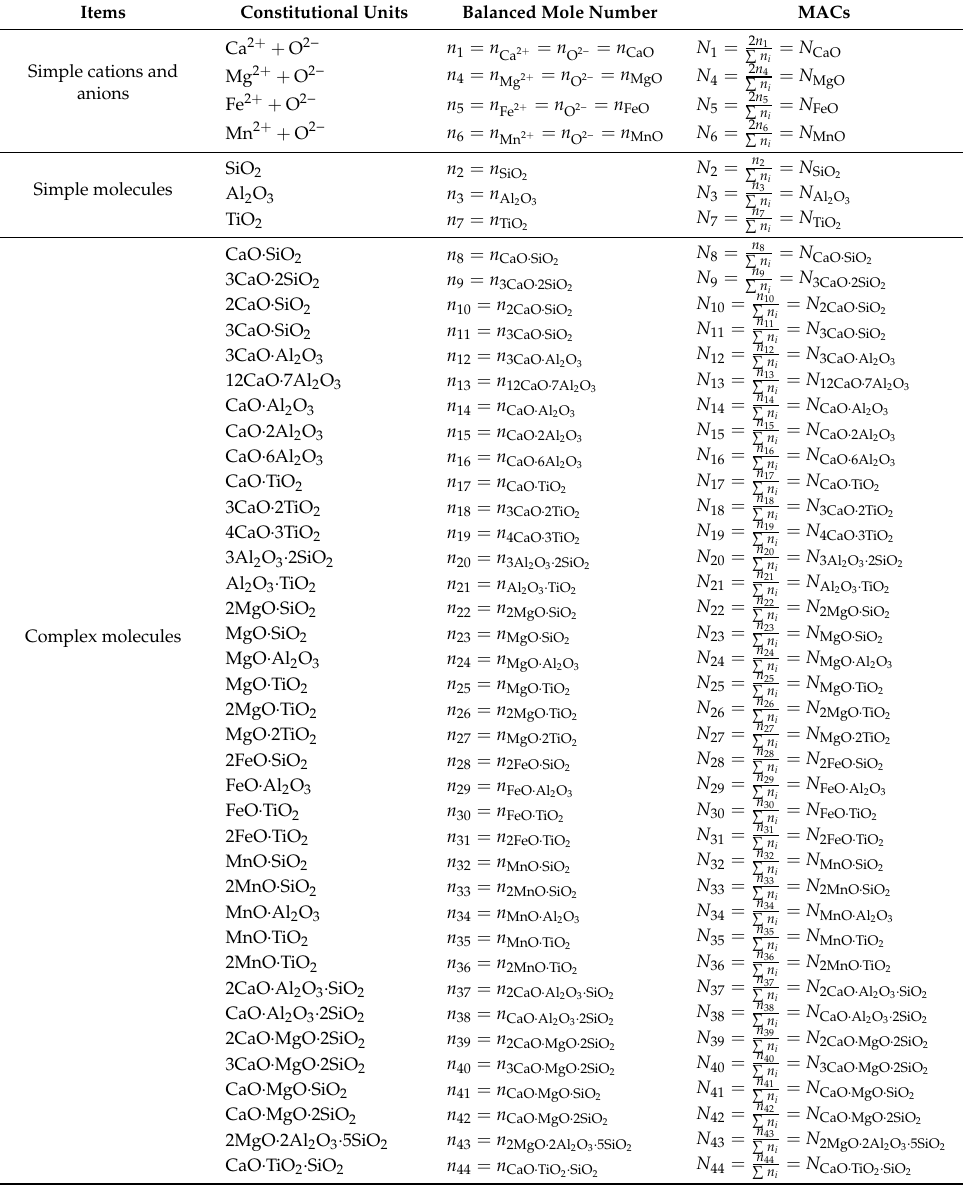
Table 3. Parameters of structural units in the slag system at 1853